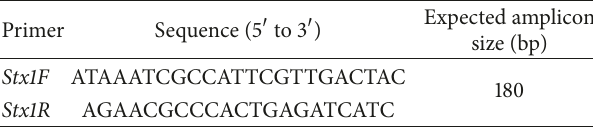
Table 1: Sequences of oligonucleotides used for